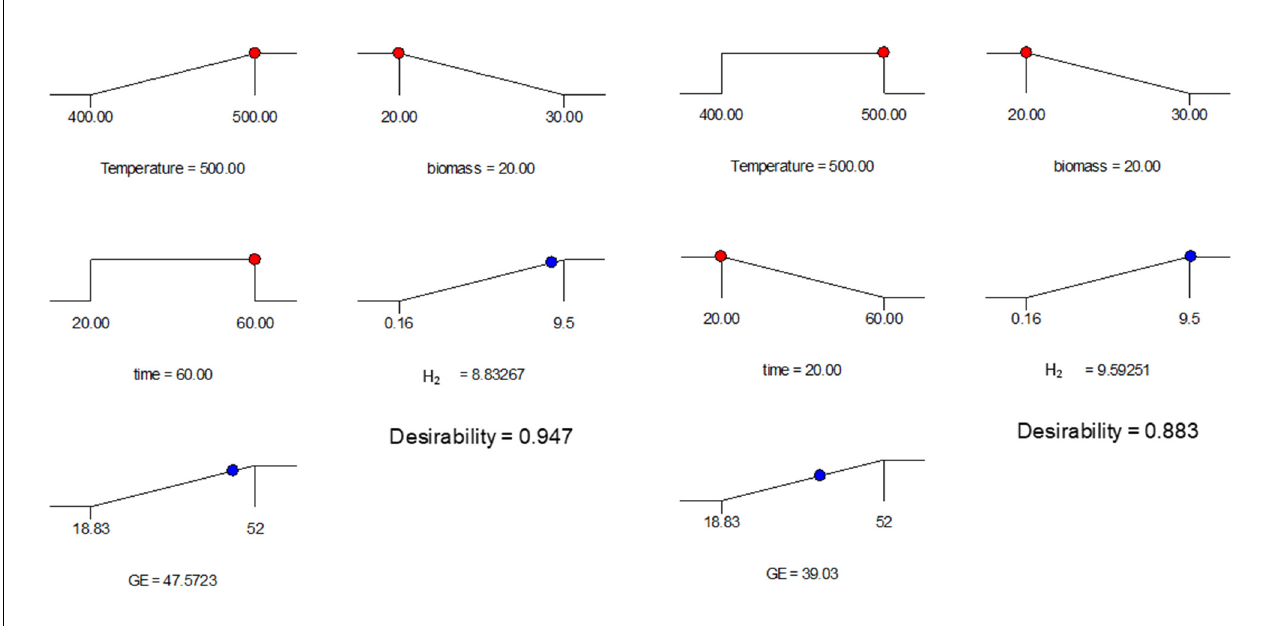
Figure 14. Ramps represent the best variables conditions for scenarios 1 and